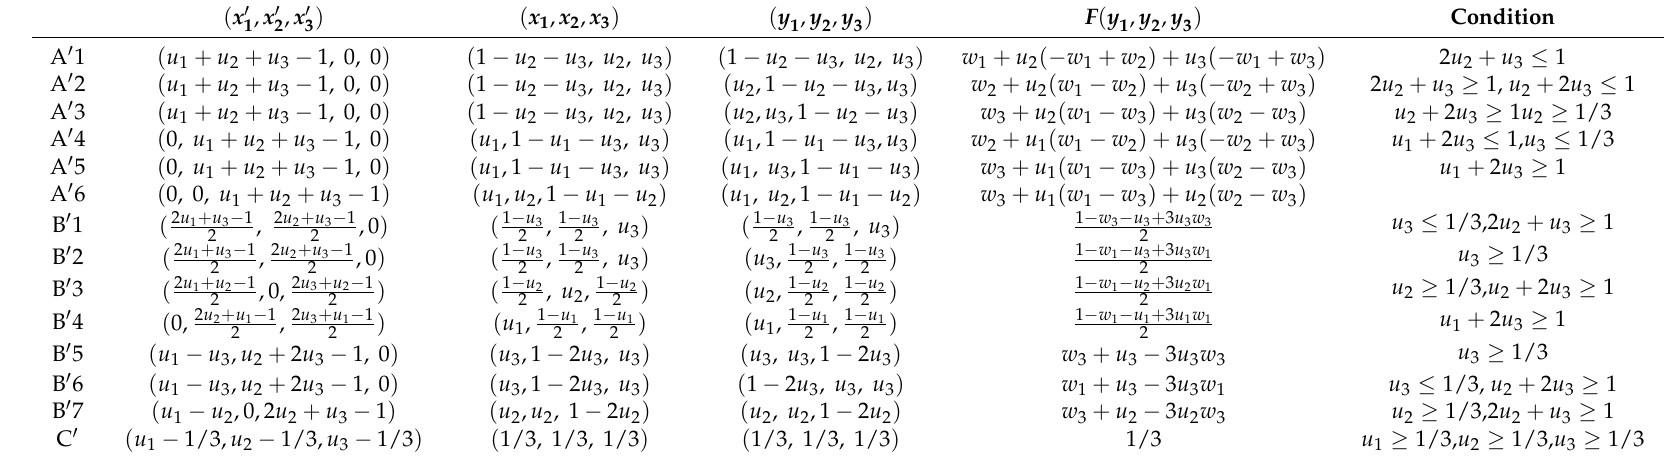
) , ( x ) and ( y , x (cid:48) , x (cid:48) 1 , x 2 , x 3 2 3 1